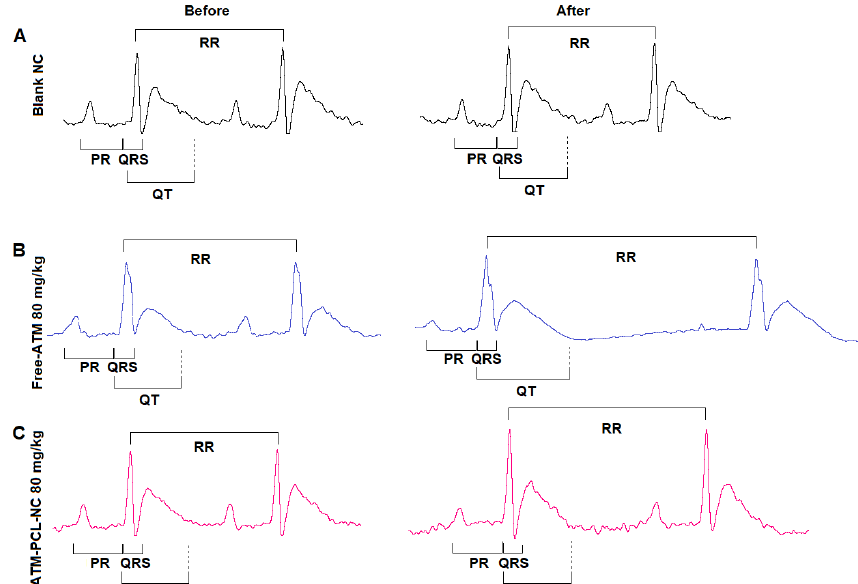
Figure 5. Representative ECG signal (lead II) at basal (before treatment) and after treatment with Blank-NC in ( A ), Free-ATM in ( B ) and ATM-PCL-NCs in ( C ), showing the ECG intervals analyzed. The RR interval was used to obtain the heart rate (HR). Polymers 2022 , 14 , x FOR PEER REVIEW